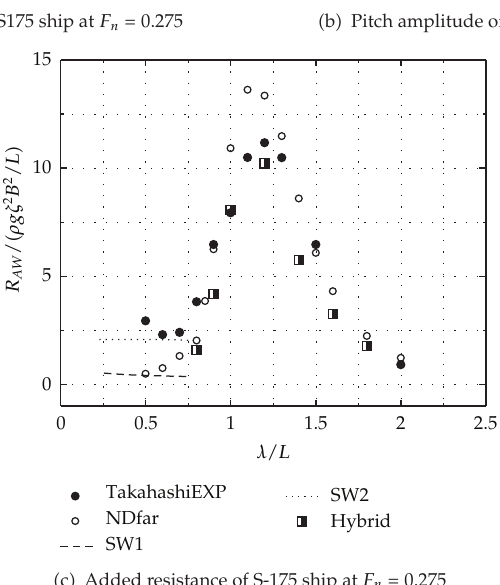
Figure 10: Motion amplitude of S175 ship at F n (cid:7) 0 .